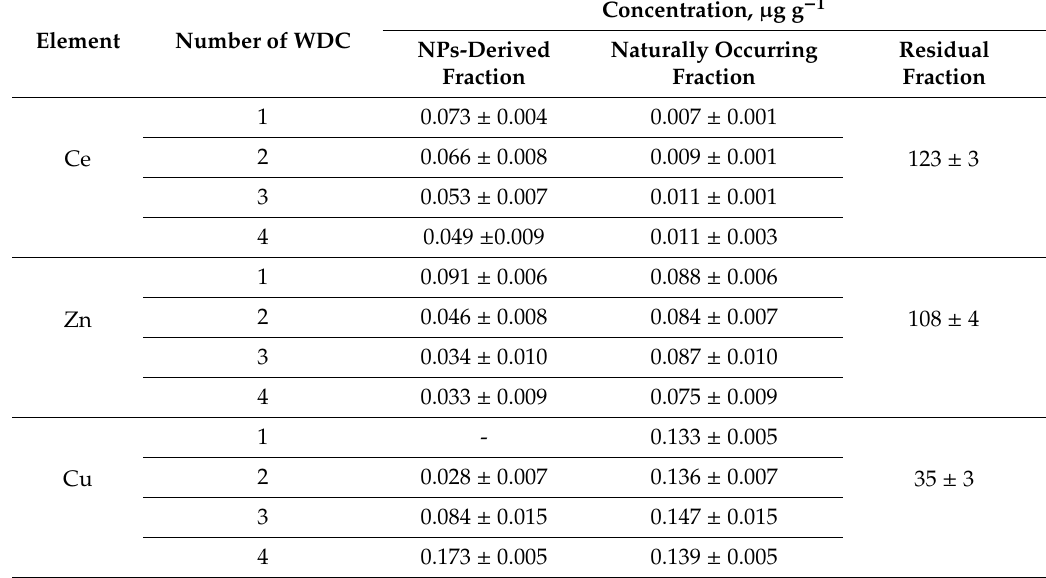
Table 2. Concentration of Ce, Zn, and Cu in soil fractions as obtained by inductively coupled plasma mass spectrometry (ICP-MS) ( mean ± standard deviation ).